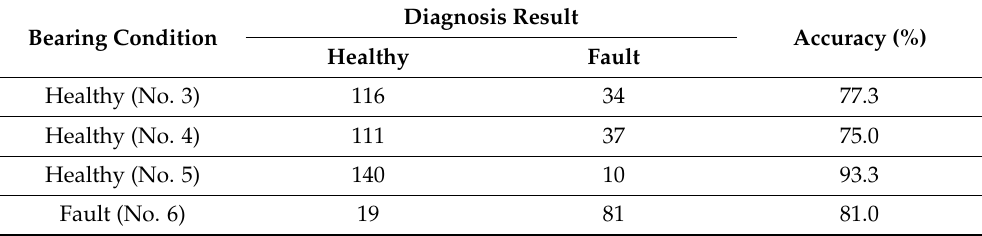
Table 6. Diagnosis result based on Random Forest.